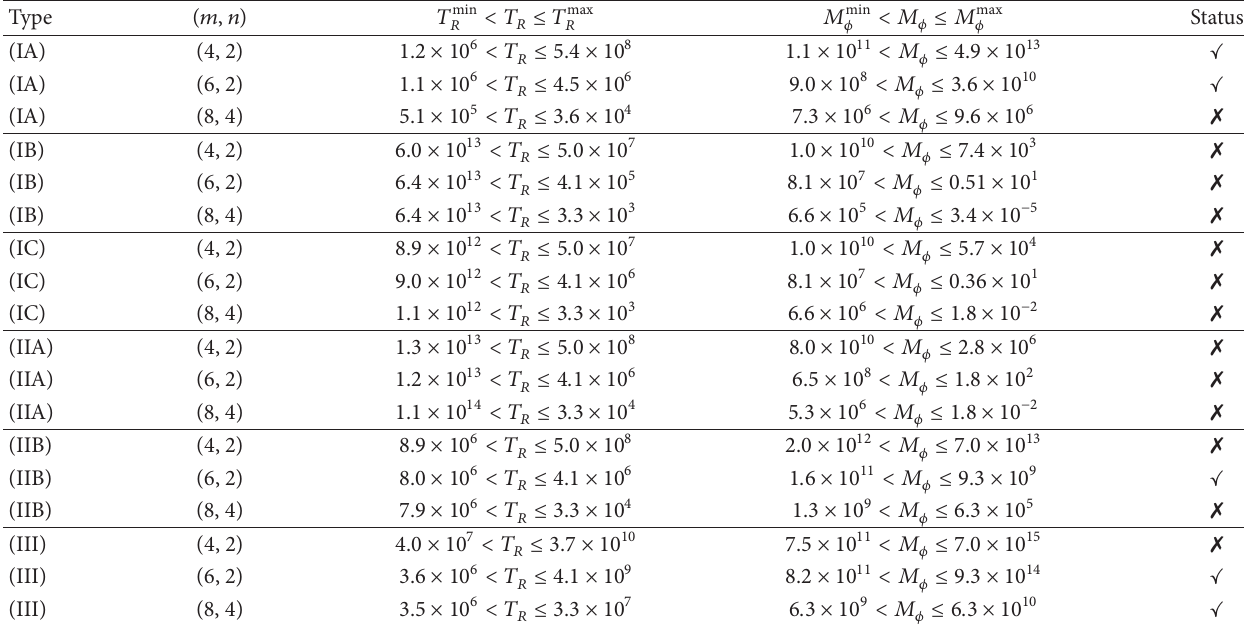
Table 3: Theoretical bound on reheating temperature 𝑇 𝑅 and inflaton masses 𝑀 𝜙 in nonthermal leptogenesis, for all neutrino mass models with tan 2 𝜃 12 = 0.45 . Models which are consistent with observations are marked in the status column.